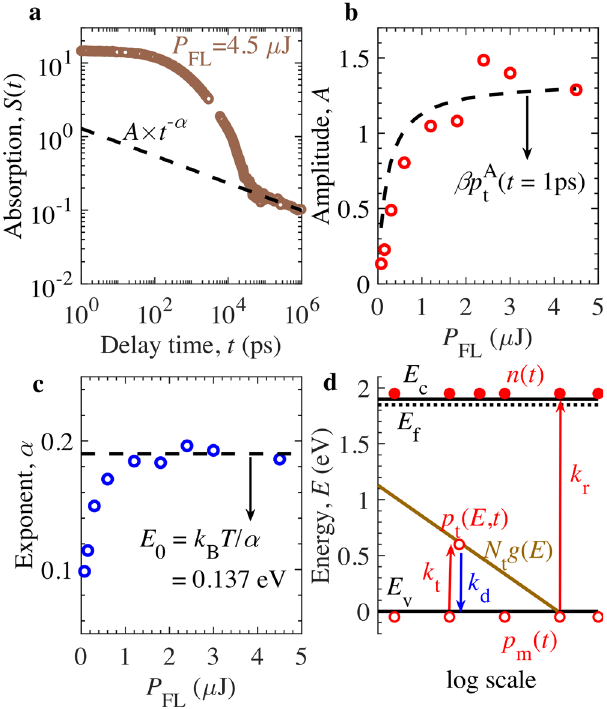
Fig. 3 Late-time decay analysis of TDR signal of Y 2 Ti 2 O 5 S 2 photocatalyst. a TDR pro fi le at pump fl uence intensity P FL ¼ 4 : 5 μ J and probe photon energy of 0.24 eV fi tted with the power law: A ´ t (cid:2) α . b , c Variation of estimated amplitude A and exponent α with P FL . In b and c , the dashed lines correspond to the analytical solution from Eq. (2) at trap density N t ¼ 5 : 1 ´ 10 17 cm (cid:2) 3 and energy dispersion parameter α ¼ 0 : 19 ( E 0 ¼ 0 : 137eV). Fig. 4 Theoretical analysis of decay kinetics of TDR signal of Y 2 Ti 2 O 5 S 2 d , Proposed model schematic showing exponential tail-states of VB photocatalyst. a Numerical (solid line) and analytical model (dotted line) ( N t g ð E Þ ) along with bimolecular band-to-band transition of mobile electrons calibration with the measured normalized TDR signal S ð t Þ = S ð 0 Þ (circle) ; and k measured at pump fl uence intensity P FL ¼ 3 μ J and probe photon energy of and trapping/detrapping of holes. Here, k , k are the corresponding r t d rate constants, whereas p m t ð Þ ; p t E ; t ð Þ ; and n ð t Þ are the density of mobile 0.24eV. b Mapping of calculated trapped hole density p t E ; t ð Þ in cm − 3 eV − 1 holes, trapped holes at energy E , and electrons at time t after across energy E , mobile electron (solid circles) and hole density (open photoexcitation, respectively. Source data are provided as a Source circles) in cm − 3 at different decay time t . Source data are provided as a Data fi le. Source Data fi